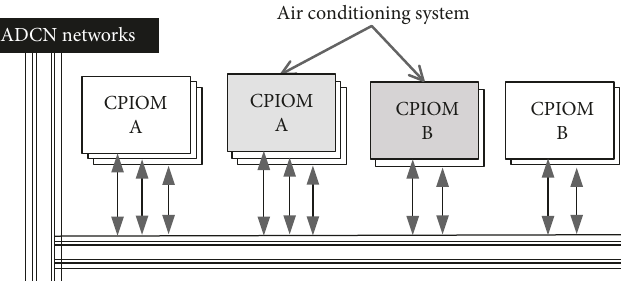
Figure 2: Air conditioning function residing on CPIOM of A380.